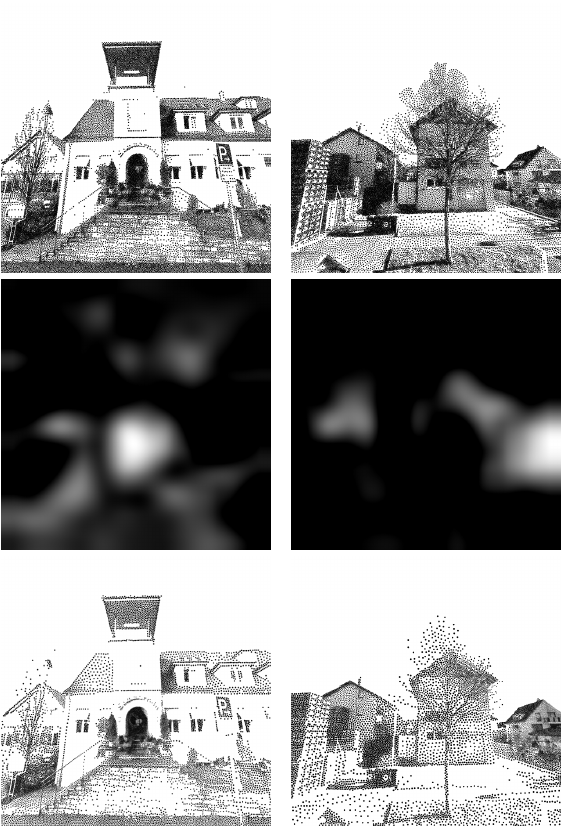
Figure 8. Created stipple drawings without ( top ) and with ( bot- tom ) usage of the grayscale CAMs ( center ) to focus the user’s attention. Left : focus on the door area, right : focus on the build- ing in the right